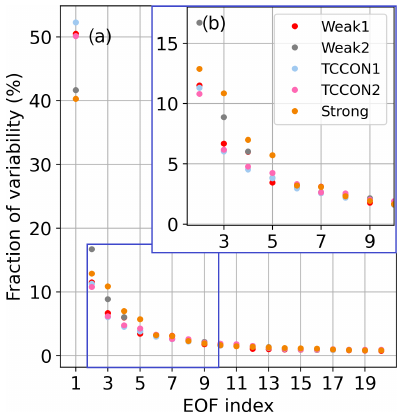
Figure E1. Fraction of the variability in the spectral residuals ac- counted for by each empirical orthogonal function in each CO 2 win- dow. The EOF numbers are shown in decreasing order of singular value. Panel (b) highlights the blue rectangle inside panel (a)